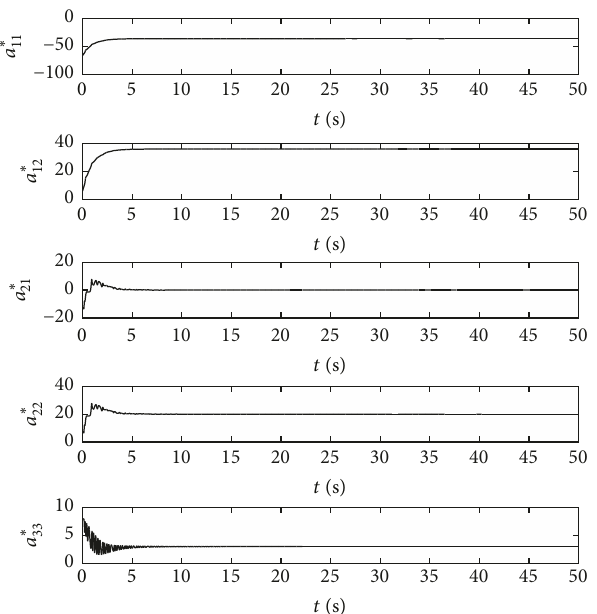
Figure 2: Estimated parameters of the L¨u system finally evolve to the true values (𝑎 11 ,𝑎 12 ,𝑎 21 ,𝑎 22 ,𝑎 33 ) = (−36,36, 0, 20, −3) .